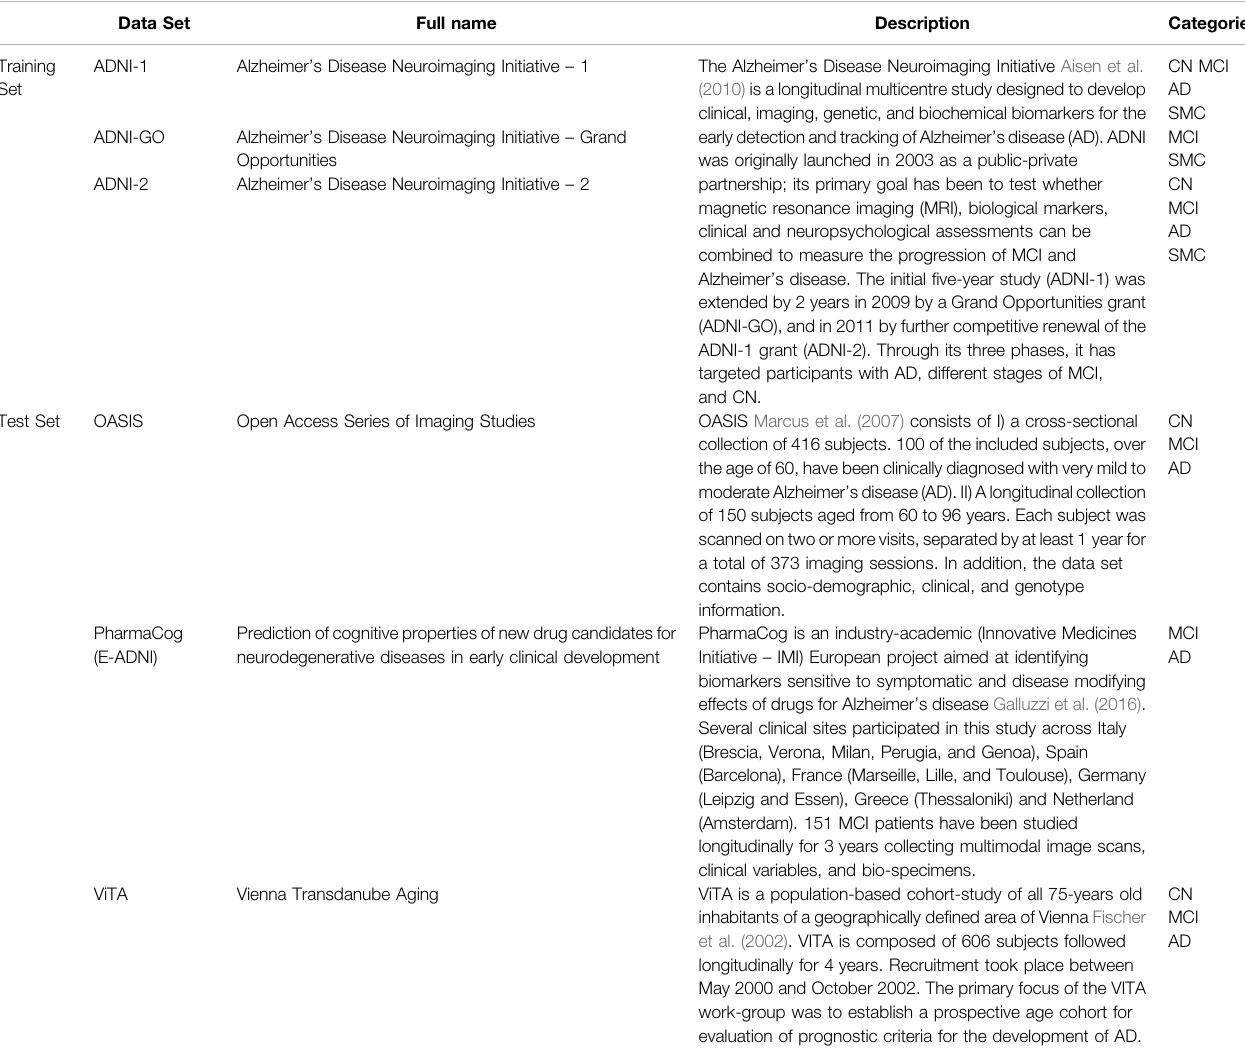
TABLE 1 | Characteristics of the data sets